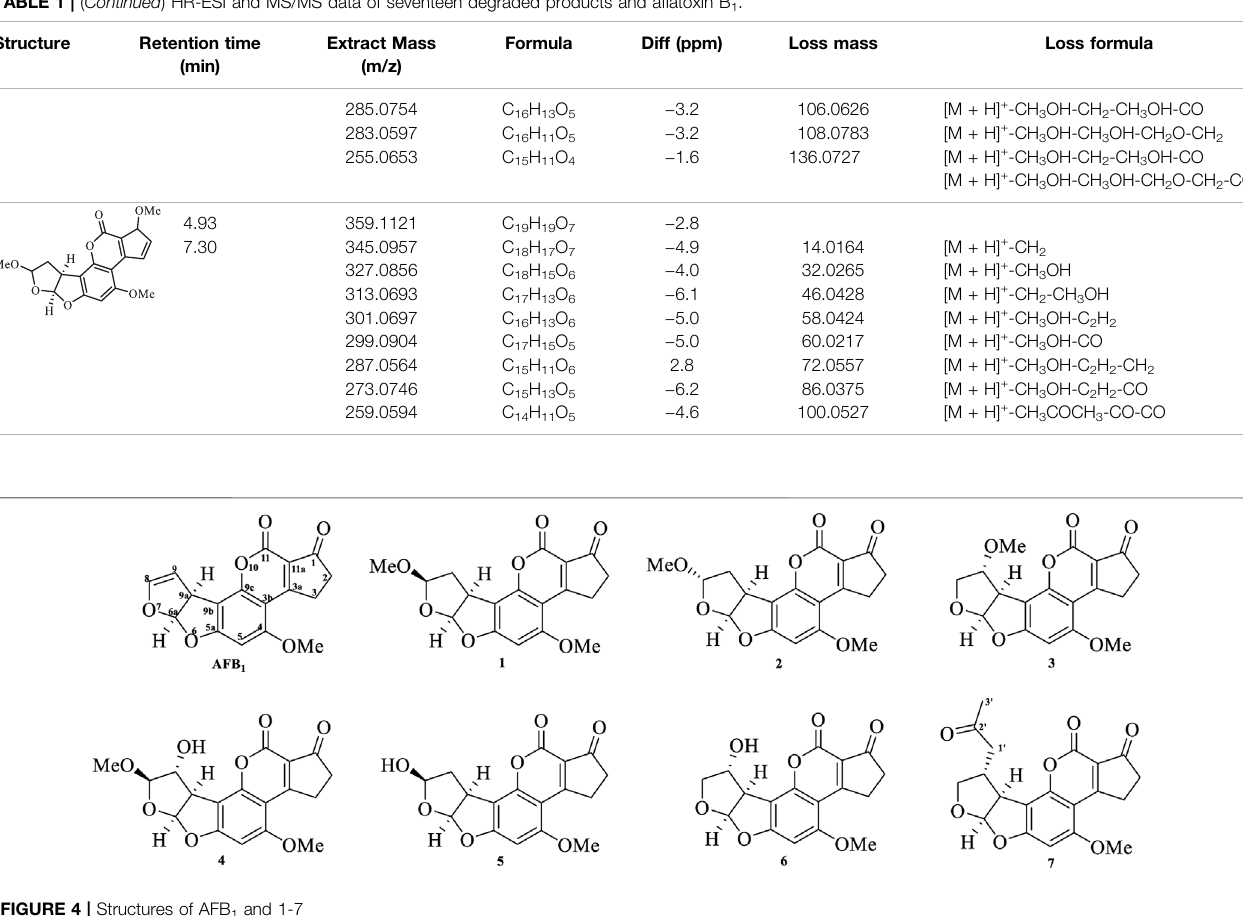
with 16 Da (O) more than that of degraded products ( m / z 331), indicating two hydroxyl groups connected on C 8 and C 9 , respectively ( Supplementary Figure S7 ). The possible fragmentation pathway is suggested in Supplementary Figure S7 . The molecular formula of the ion at m / z 371 ([M+1], t R (cid:2) 4.34 and 5.63 min) was determined to be C 20 H 18 O 7 based on HR-ESI- MS with 58 Da (CH 3 COCH 3 ) more than that of AFB 1 ( m / z 313) ( Supplementary Figure S8 ), which implied that one molecule of acetone attacked on C-8 or C-9 under UV irradiation. The possible fragmentation pathway of them is suggested in Supplementary Figure S8 . The molecular formulas of ions at m / z 401 ([M+1], t R (cid:2) 4.86 and 6.54 min) were determined to be C 21 H 20 O 8 based on HR- ESI-MS. The loss of 32 Da from m / z 401 to m / z 369 and the loss of 58 Da from m / z 401 to m / z 343 suggested that a methoxyl and acetone were connected on C-8/C-9 or C-9/C-8 ( Supplementary Figure S9 ). The possible fragmentation pathway of these two ions is suggested in Supplementary Figure S9 . Though seventeen degraded products were characterized by molecular formula and fragment ions, the planar structures and con fi gurations of some degraded products could not be